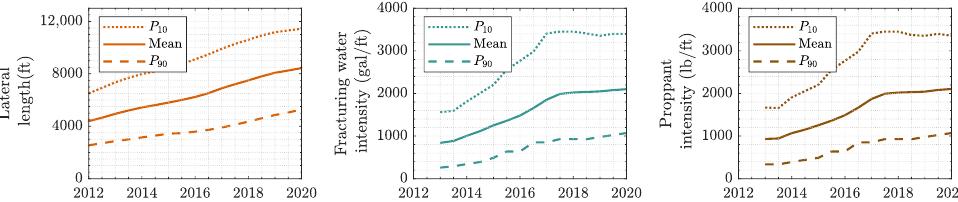
Figure 3. Advancement of drilling and completion technologies in the Permian. Lateral lengths, fracturing water intensity, and proppant intensity have increased more than two-fold over the last eight